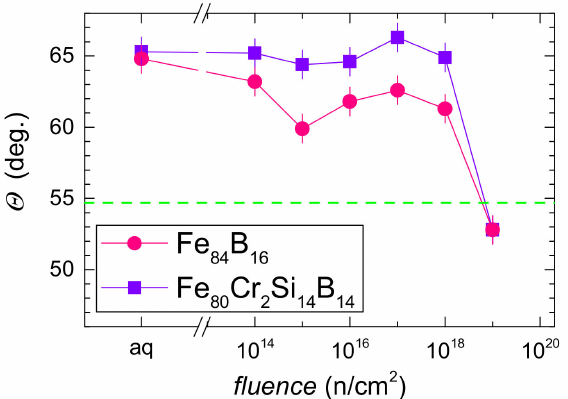
Figure 5. Positions of net magnetic moments characterized by the angle Θ of the Fe 80 Cr 2 Si 14 B 14 and Fe 84 B 16 plotted against neutron fluence. The green dashed line represents the magic angle (54.7 ◦ ), which corresponds to random orientation of spins.